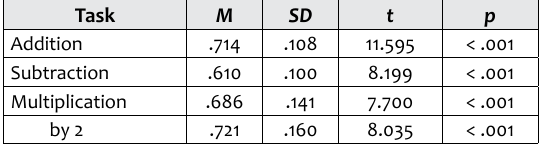
Table 1: Achievement (relative frequencies of correct solutions) within